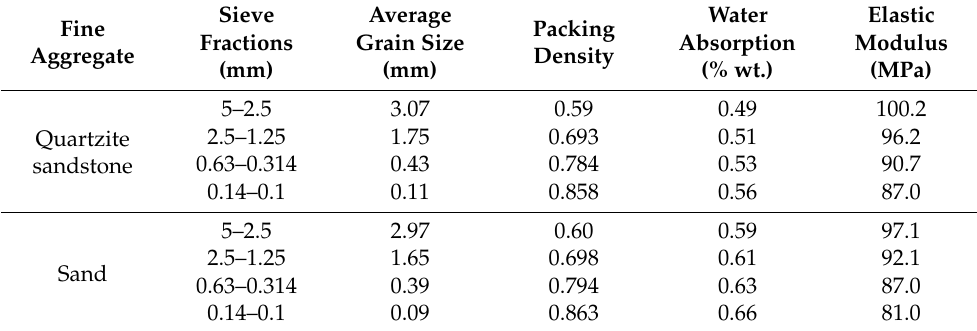
Table 4. Characteristics of quartzite sandstone and